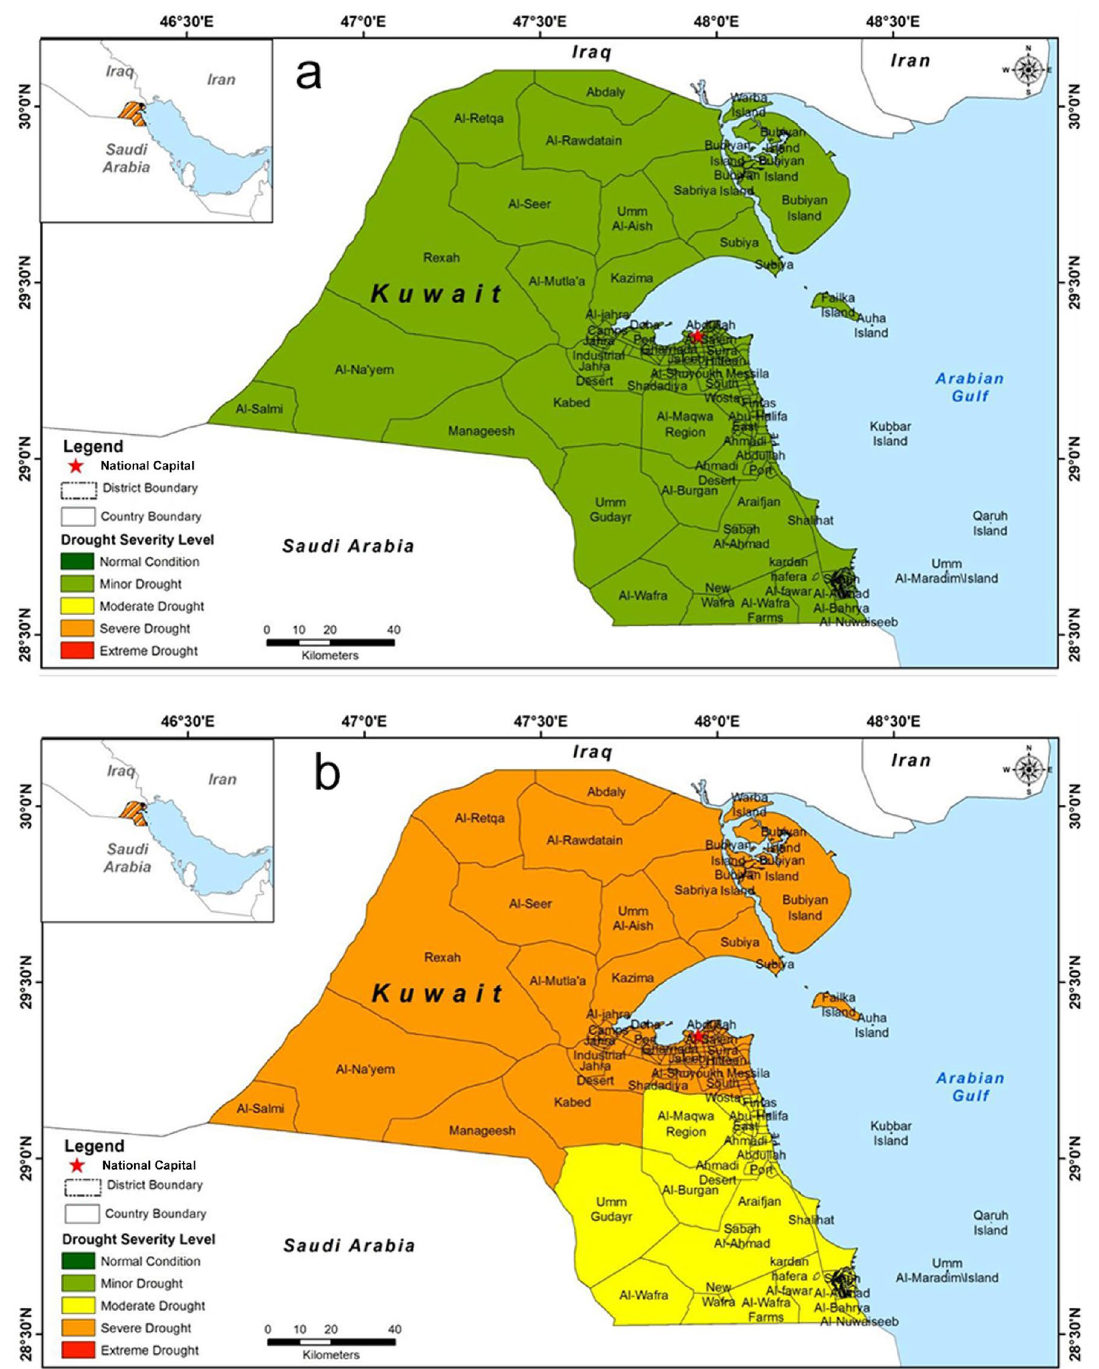
Fig. 9 Drought hazard maps for Kuwait for different return periods based on rainy season total rainfall data in 1981–2018: a 5 year; b 10 year; c 19 year; and d 38 year. Source Kuwait Institute for Scientific Research